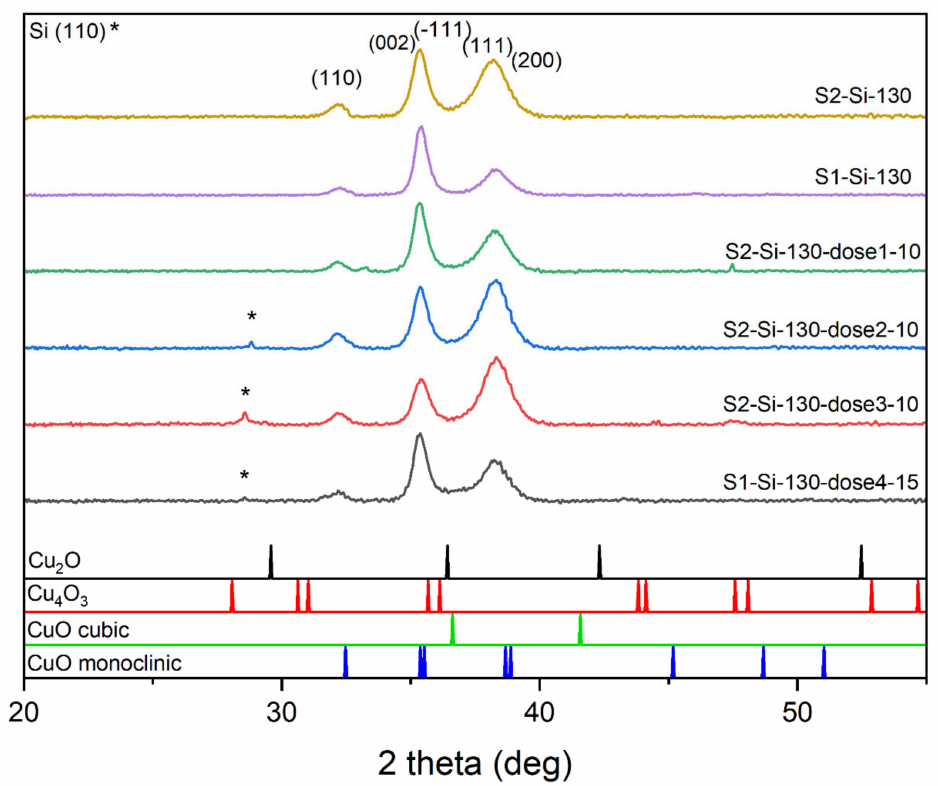
Figure 3. Diffractograms of the chosen CuO sample with the same thickness showing influence of different implantation dose.